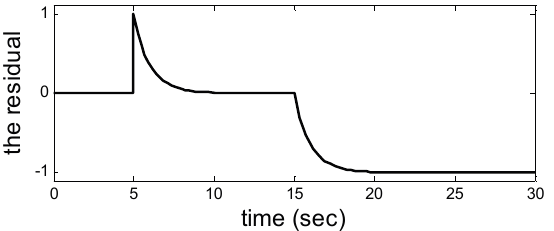
Figure 8. The residual when a = 1 and b =